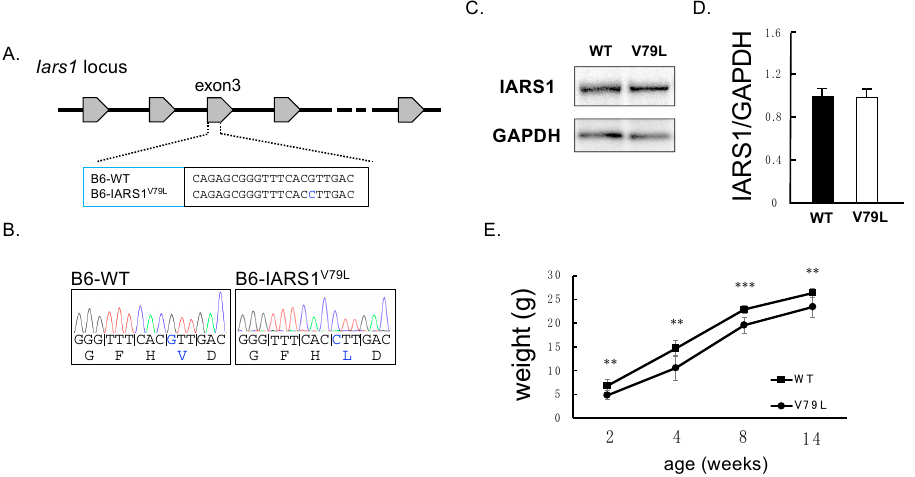
Figure 1. Generation of IARS1 V79L mice using a CRISPR/Cas9 system. ( A ) Single-nucleotide poly- morphism (G235C) and amino acid substitution (V79L) are illustrated. ( B ) DNA sequencing elec- tropherogram at codon 79 of IARS in B6 and IARS1 V79L mice. ( C , D ) Western blot analysis showing no deference in IARS1 in B6 and IARS1 V79L mice ( n = 3). ( E ) The temporal fluctuations in the body weight of B6 ( n = 7) and IARS1 V79L ( n = 7) male mice were monitored and recorded. ** denotes p < 0.01. *** denotes p <